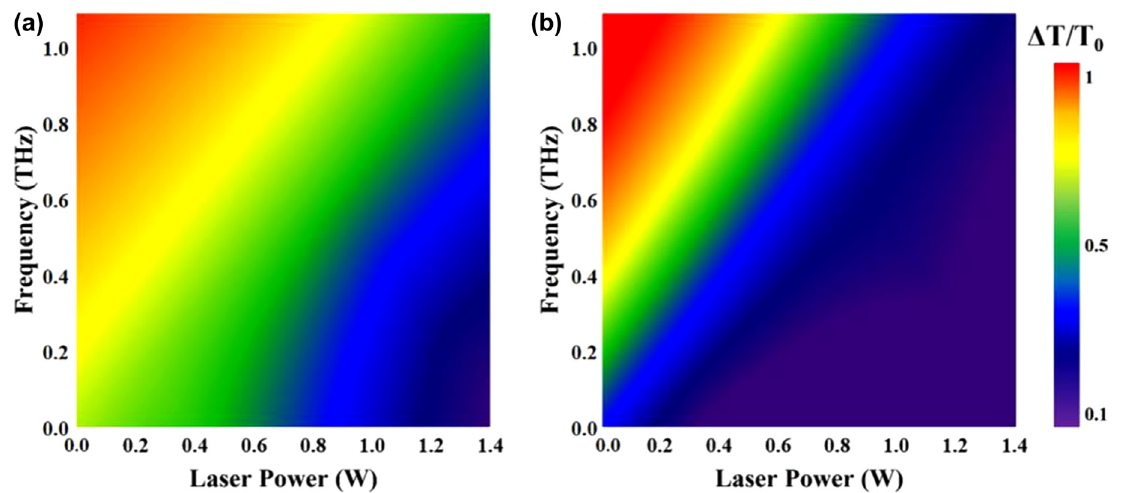
Figure 5: The frequency resolved transmission change spectra under different pump powers. (a) without SRRs and (b) with